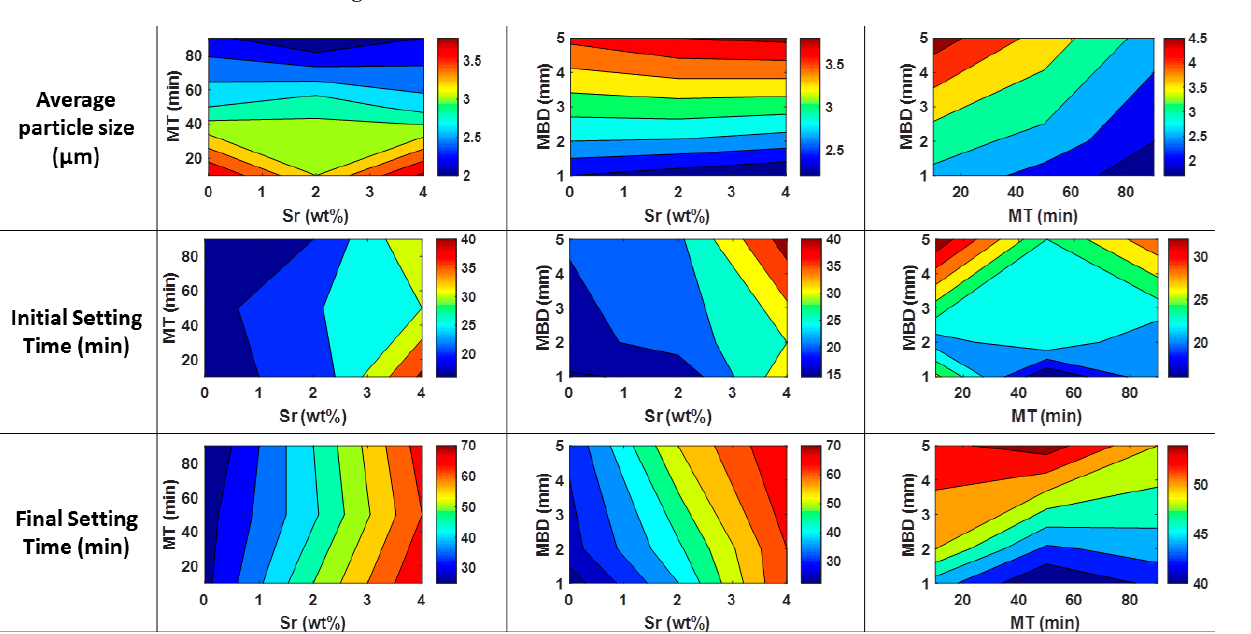
Figure 6. Contour plot related to the effect of strontium amount (Sr) and milling balls diameter (MBD) on the compressive strength of the cements, reported in the colored scale bar, from blue (lower values) to red (higher values).